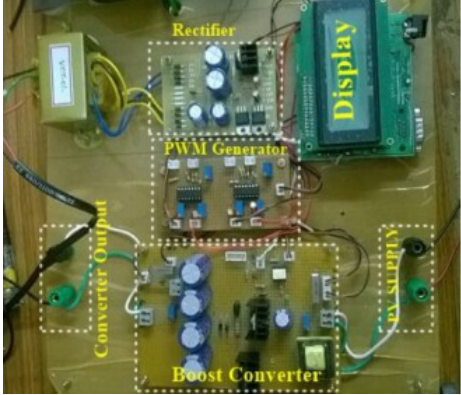
Fig. 11. Hardware Prototype of Boost Converter